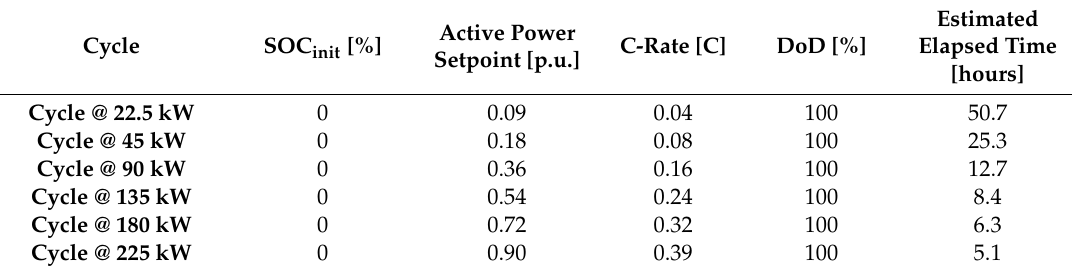
Table 3. The layout of test Set